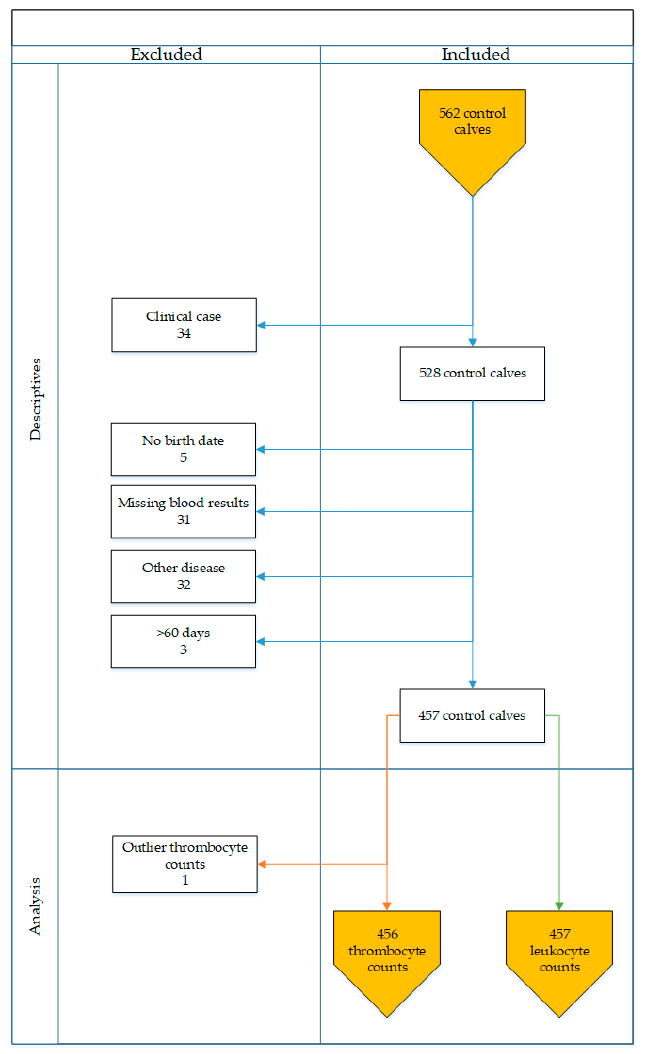
Figure 1. Schematic overview of calves included and excluded from the field study.